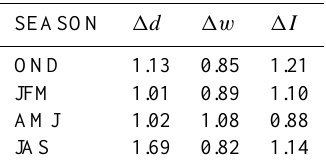
Table 3. Expected change factors of the storm statistics due to the alteration of the rainfall regime (A1b scenario) between the 21st century RCM run (2003–2030) and the reference RCM run (1961–